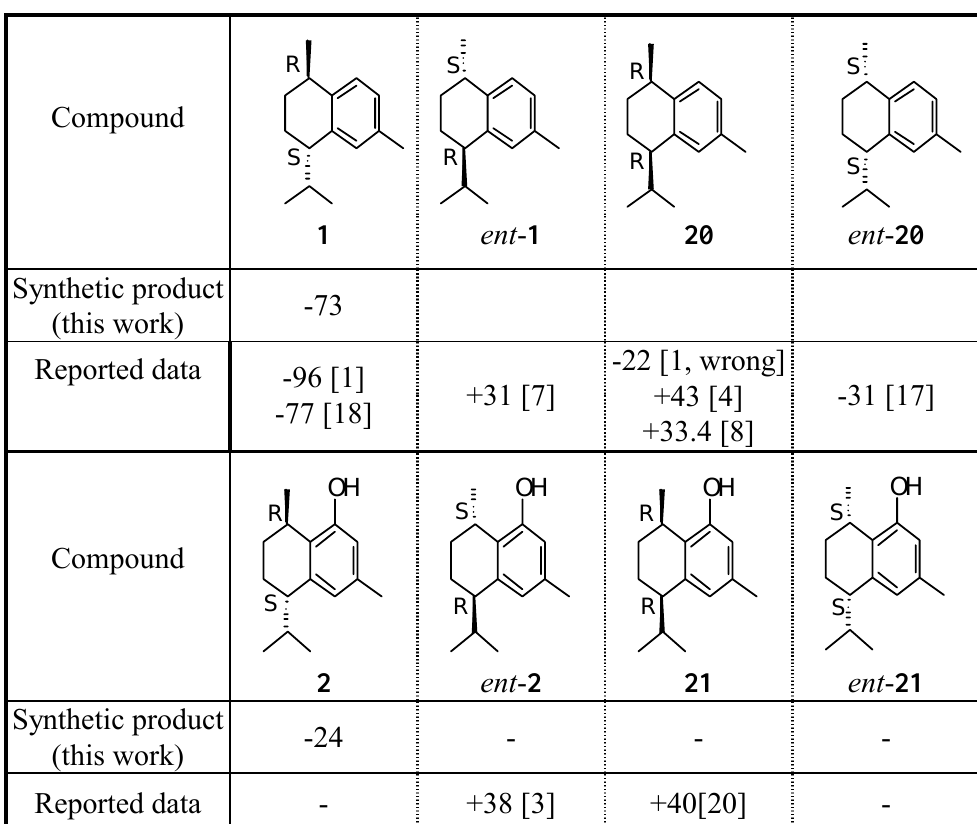
Table 1. Comparison of specific